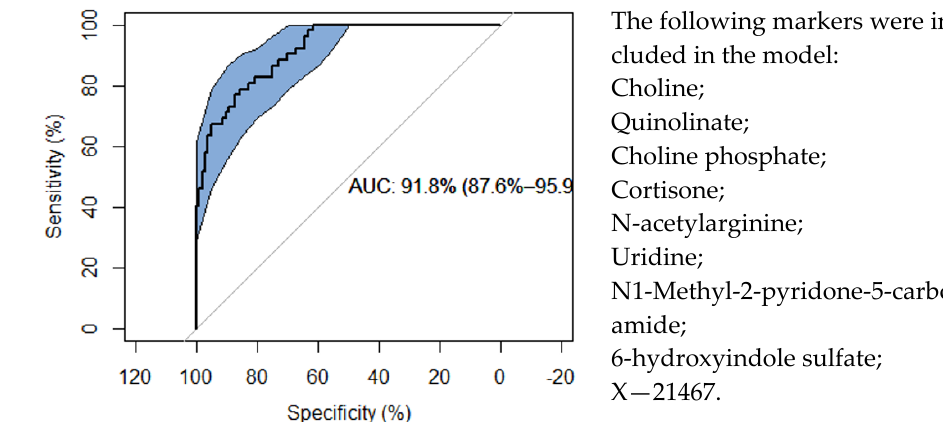
Figure 6. ROC curve for a nine-marker model to discriminate acute rejection from no-rejection samples. We used random forest to pre-select the 25 most discriminating metabolite markers and then constructed a logistic classification model using glm.lasso with stability selection, including eGFR and the CTOT-04 signature in the set of explanatory variables. Note that while proposed as model terms, neither eGFR nor the CTOT-04 signature were selected for inclusion in the prediction model. The area under the curve (AUC) and its confidence interval are provided.